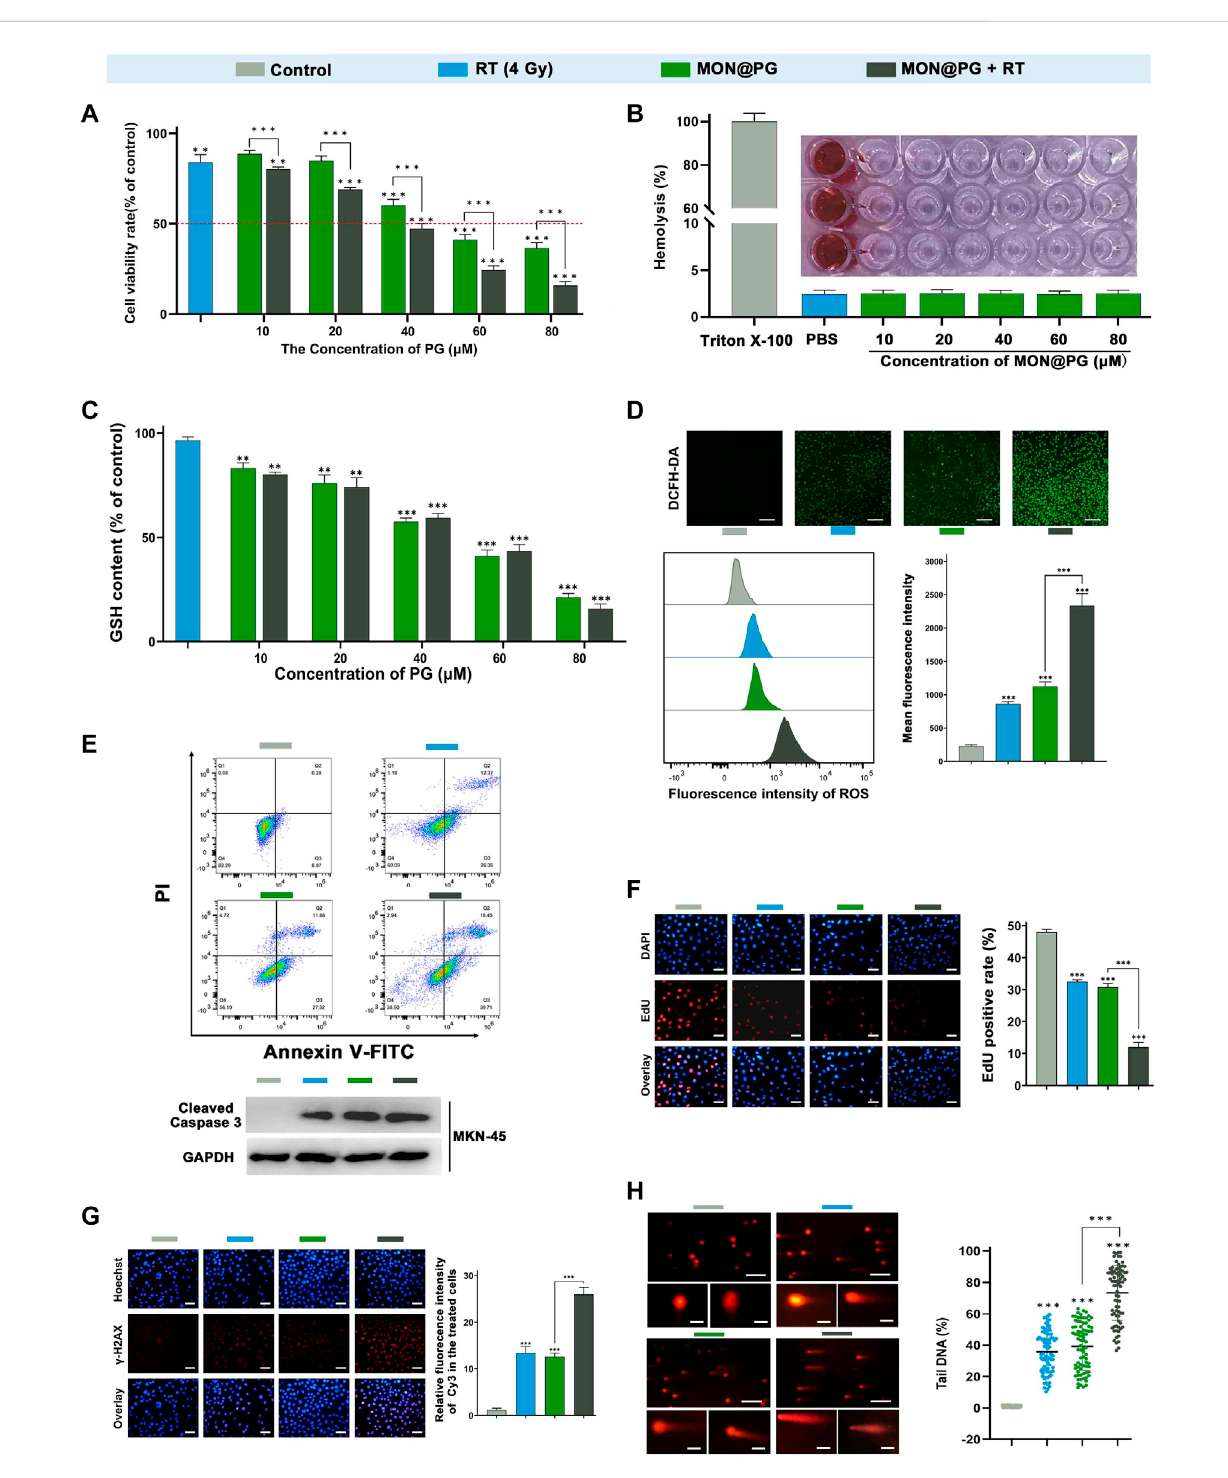
FIGURE 2 In vitro antitumor ef fi cacy of MON@PG in MFC cells with different treatments. (A) Cell viabilities of different treatment groups measured by CCK-8 assays. (B) Hemolysis assay of different concentrations of MON@PG incubated with red blood cells extracted from rabbits. (C) The GSH content of MFC cells following treatments of various concentrations of MON@PG with or without RT. (D) Fluorescence microscopic images of DCFH-DA stained MFC cells (upper). Flow cytometry (lower left) and related analysis (lower right) of DCFH-DA fl uorescence following different treatments. Scale bars: 100 μ m. (E) Cell apoptosis fl ow cytometry (upper) of MFC and Western blotting of cleaved caspase-3 in MKN45 cells (lower) following different treatments. (F) EdU images (left) and associated analysis (right) in different treatment groups. Scale bars: 30 μ m. (G) γ H2AX immuno fl uorescence images (left) and associated analysis (right) of DNA damage levels in different treatment groups. (H) Comet assay of PI fl uorescence stained DNA damage accumulation(left)andrelatedanalysis(right)indifferenttreatmentgroups.Scalebars:200 μ m;embeddedinset:5 μ m.Scalebars:30 μ m.Outcomesare displayed as mean ± SD (n = 3, *** p <